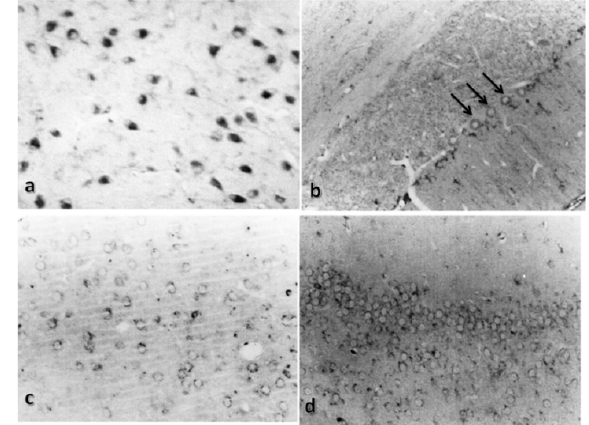
Figure 3. Immunolocalization of cathepsin B in control rats. Representative micrographs of ( a ) the trapezoid body, 20×; ( b ) the cerebellum, 20×; ( c ) the cerebral cortex, 20× and ( d ) the hippocampus, 20×, in a control rat. Arrows indicate cathepsin B